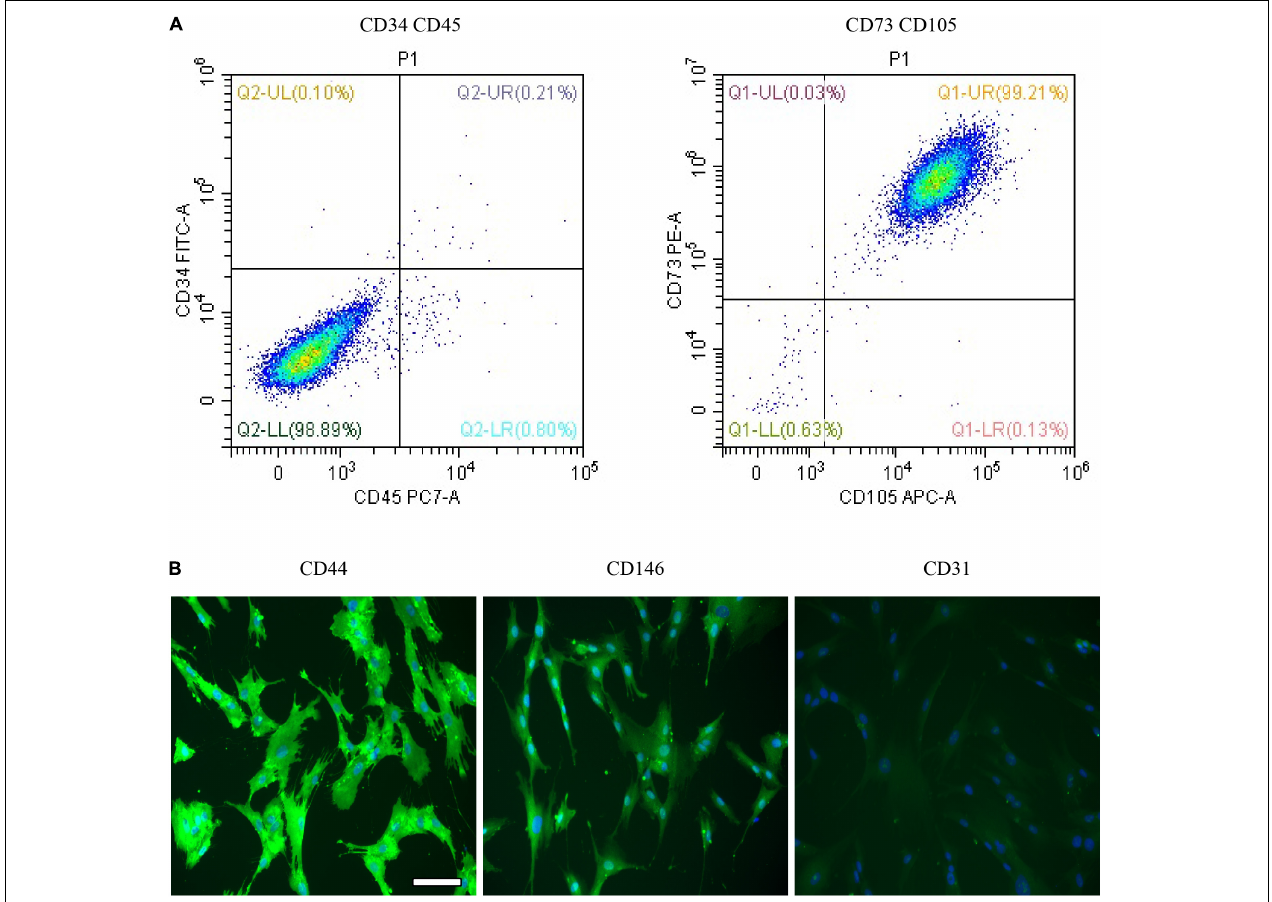
FIGURE 2 | Characterization and multipotency analysis of dental pulp stem cells (DPSCs). (A) The expression of surface markers of DPSCs. DPSCs positively expressed phenotypic markers CD105 and CD73 but negatively expressed CD34 and CD45. (B) Immunofluorescence expression of DPSC. DPSCs showed a positive expression for CD44 and CD164 but negative expression for CD31. Scale bar for (B) , 100 µ